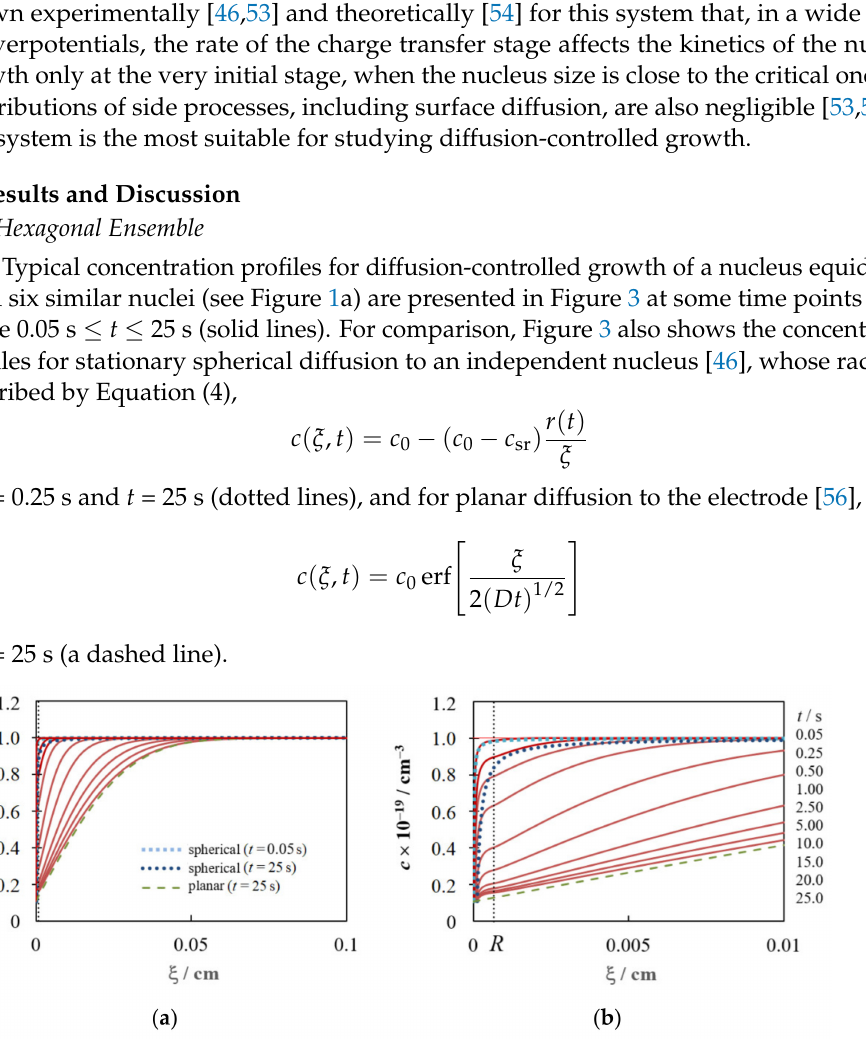
Figure 3. Concentration profiles for any nucleus within the hexagonal ensemble (dark red solid lines) for the ten t values indicated to the right of the figure ( t = 0.05 s for the top profile and t = 25 s for the bottom one). Parameter values: c 0 = 1 × 10 19 cm − 3 , η = 100 mV and R = 6.49 × 10 − 4 cm ( N 0 = 7.55 × 10 5 cm − 2 ). For comparison, the concentration profiles for spherical diffusion to the independent nucleus (dotted lines) and planar diffusion to the electrode (a dashed line) are also shown here for the same c 0 and η values and t = 0.05 s and/or t = 25 s; ( a , b ) differ only in ξ